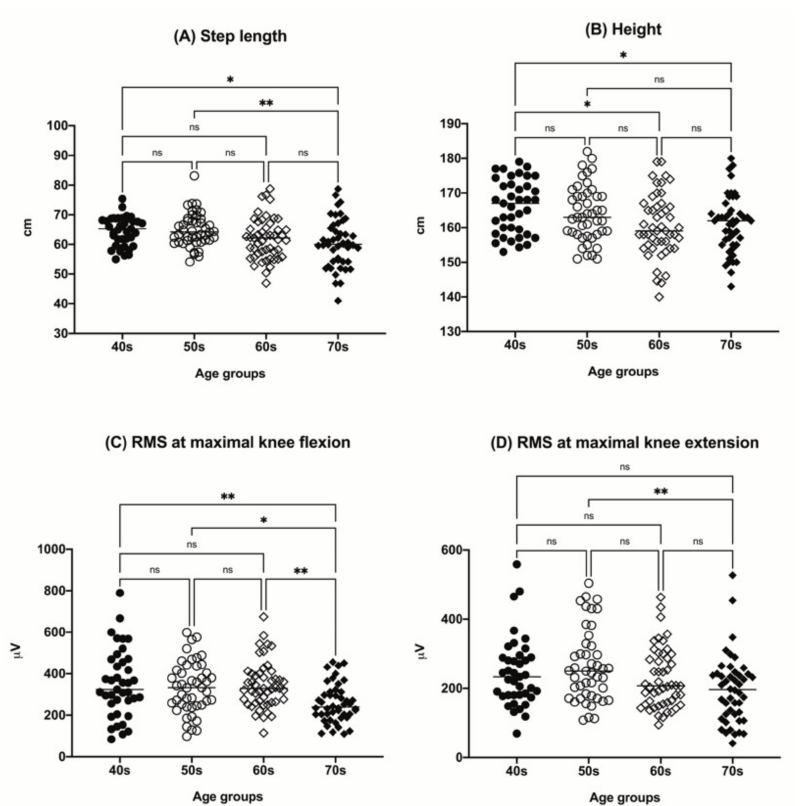
Figure 1. The distributions of participant step length ( A ), height ( B ), RMS value at maximal knee flexion ( C ), and RMS value at maximal knee extension ( D ) by age group (40s, age 40–49 years; 50s, age 50–59 years; 60s, age 60–69 years; 70s, age 70–79 years). * p < 0.05, ** p < 0.01. ns, not significant; RMS, root mean square.